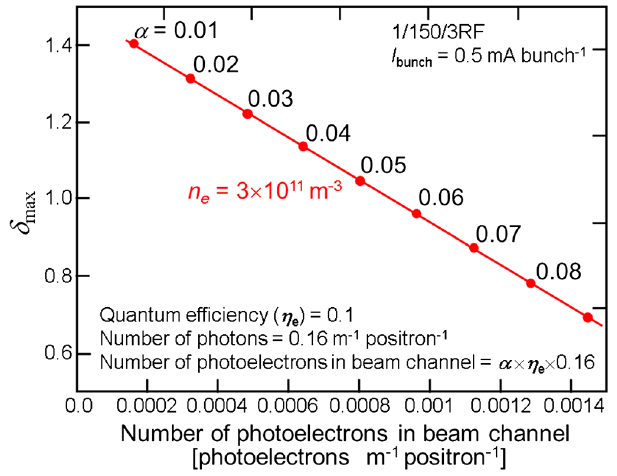
FIG. 14. Calculated results for combinations of δ number of photoelectrons in a beam channel that give the same electron density ( n e ) of 3 × 10 11 m − 3 at 900 mA for a bunch fill pattern of 1 = 1576 = 3 . 06 RF. The values of α corresponding to the number of photoelectrons are also